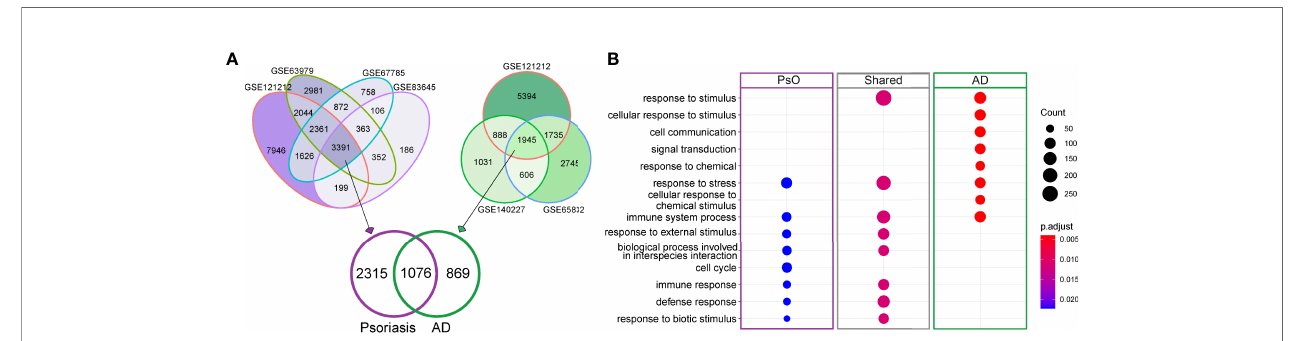
FIGURE 2 | DEGs for psoriasis and AD and GO enrichment analysis of shared and disease-speci fi c DEGs. (A) Venn diagram visualizing the overlaps in DEGs between lesional and non-lesional skin in different public datasets for psoriasis (purple) and AD (green). (B) Involved GO pathways based on the gene lists of psoriasis-speci fi c DEGs, AD-speci fi c DEGs and DEGs that are shared between psoriasis and AD. The size of dot denotes number of DEGs involved in the term, while color denotes the adjusted P value of the hypergeometric test for gene